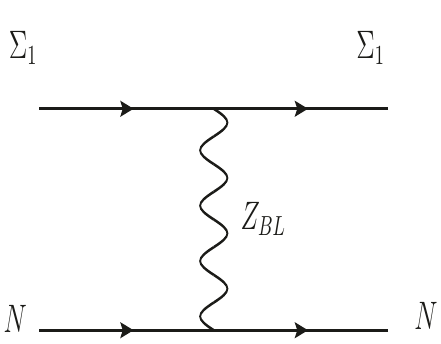
Figure 1 . Feynman diagram for the spin independent elastic scattering cross section between dark matter candidate (cid:6) 1 and the nucleon ( N ) mediated by Z BL